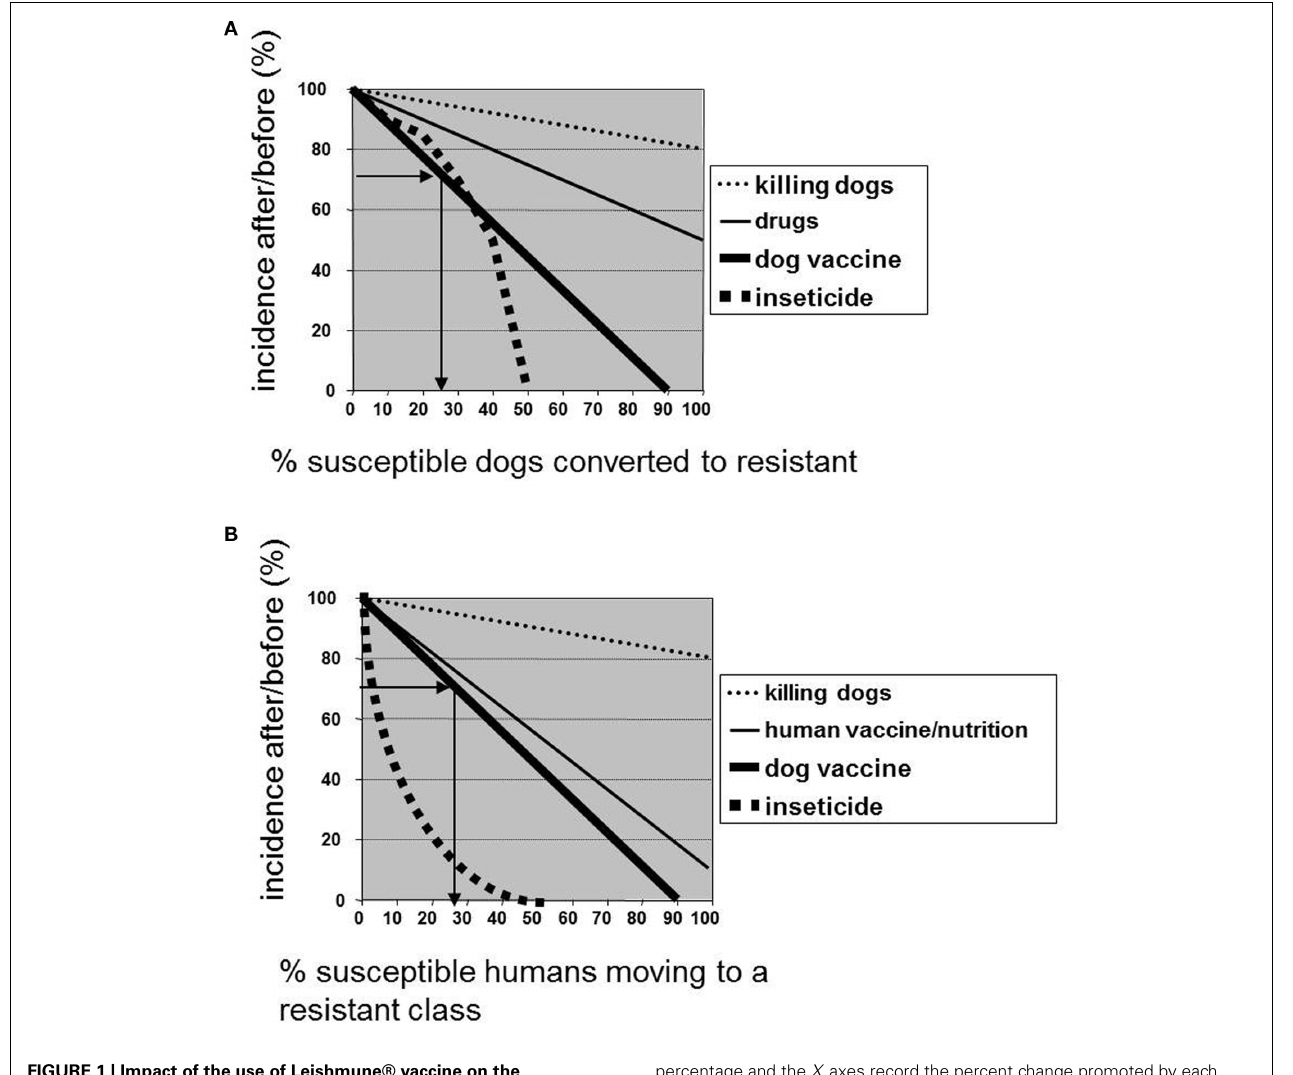
FIGURE 1 | Impact of the use of Leishmune® vaccine on the decrease of dog and human incidence of ZVL in Brazil. The curves show the expected efficacy of different control methods in bringing down the (A) prevalence of infectiousness in dogs, and (B) the incidence of human visceral leishmaniasis according to the model of Dye (1996). The y -axes show the stable prevalence (A) or incidence (B) after control, divided by the respective values before control, and expressed as a